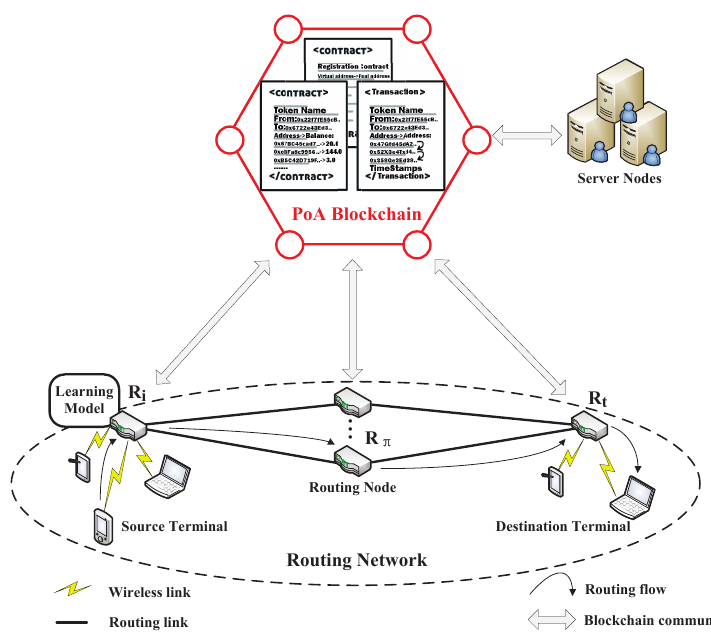
Figure 3. The framework of the blockchain-based routing